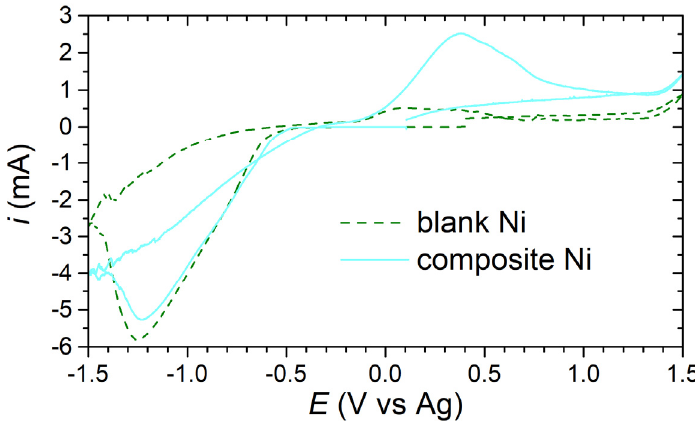
Figure 3. Cyclic voltammetry curves recorded in a blank Ni plating bath and suspension bath containing 2 g dm − 3 Ce 2 (MoO 4 ) 3 4.5H 2 O microflakes, at 70 °C on a rotating disk electrode with Pt tip (3 mm diameter), at 600 rpm.